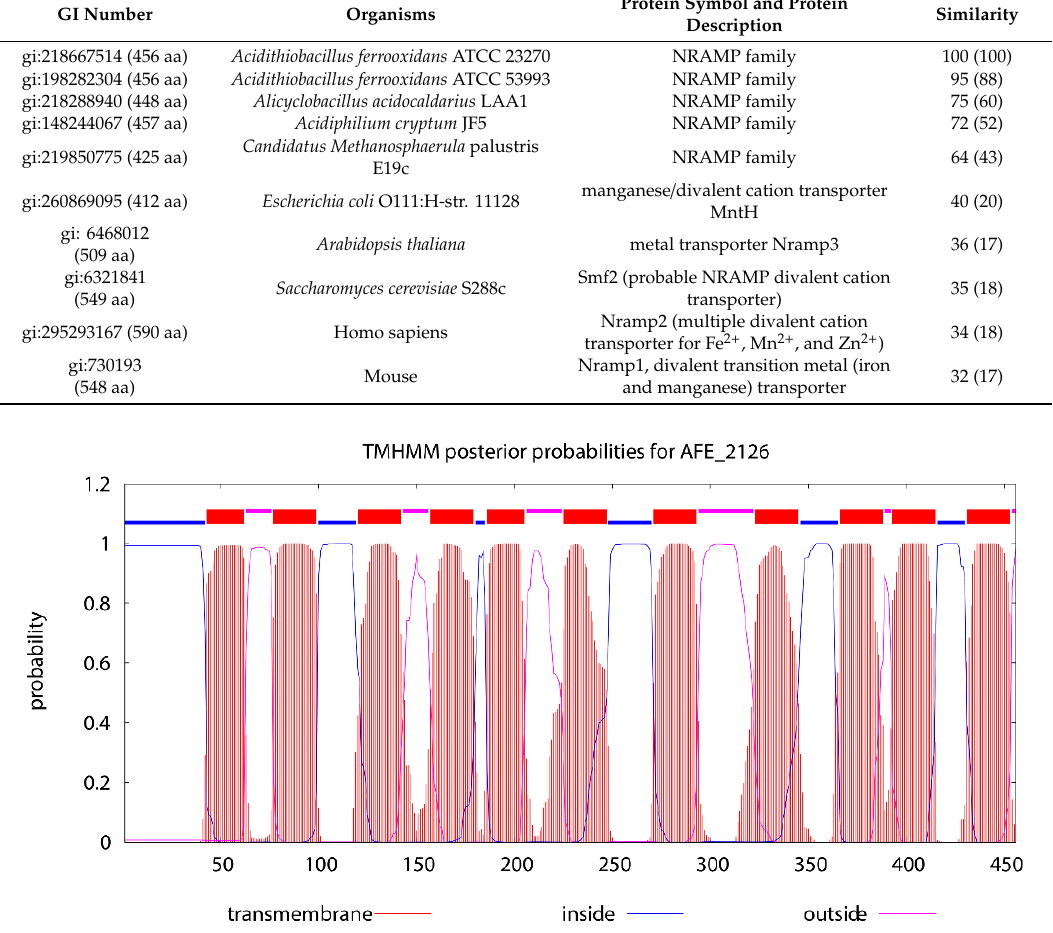
Figure 1. TMHMM posterior probabilities predictions for the transmembrane helices of the AFE_2126 protein from At. ferrooxidans of the Dachang Copper Mine (DC). A transmembrane protein analysis indicated that the N-terminus of AFE_2126 was cytoplasmic and followed by 11 transmembrane segments and that the C-terminus was periplasmic, together with the loops between transmembrane segments (TMS)1/2, 3/4, 5/6, 7/8, and 9/10.